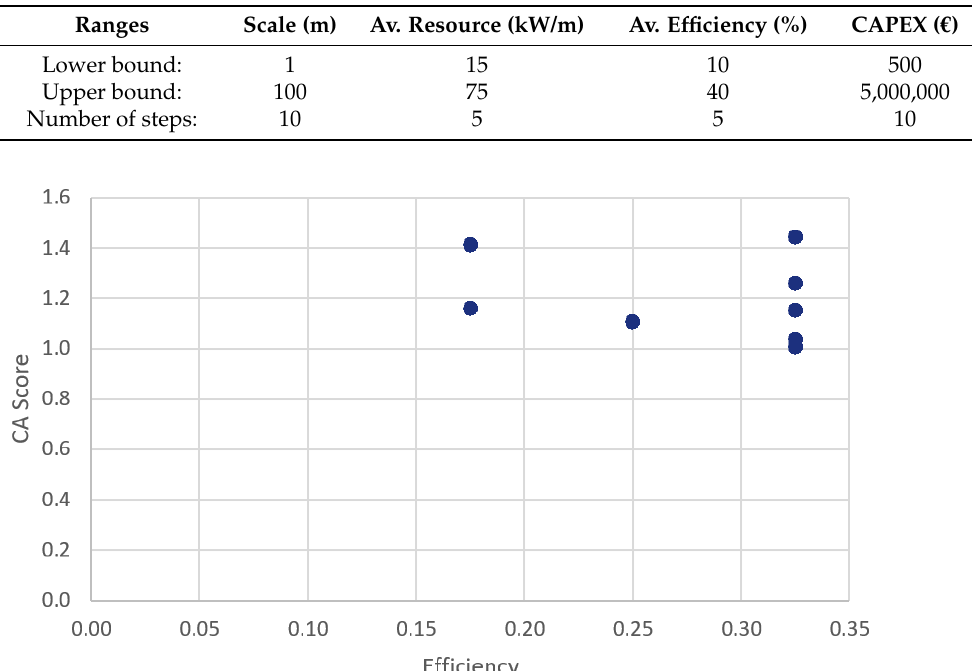
Table 12. Input ranges chosen for the zoomed in efficiency scenario (10–40%) with the other ranges of Scale, Resource and CAPEX kept wide.